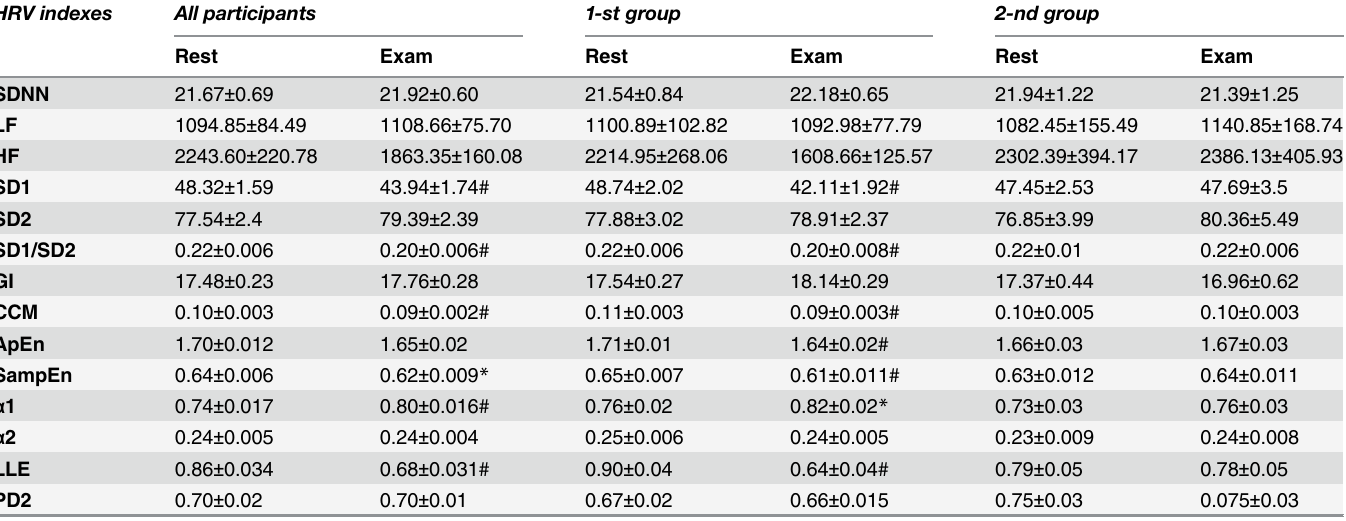
Table 3. Heart rate-corrected measures of heart rate